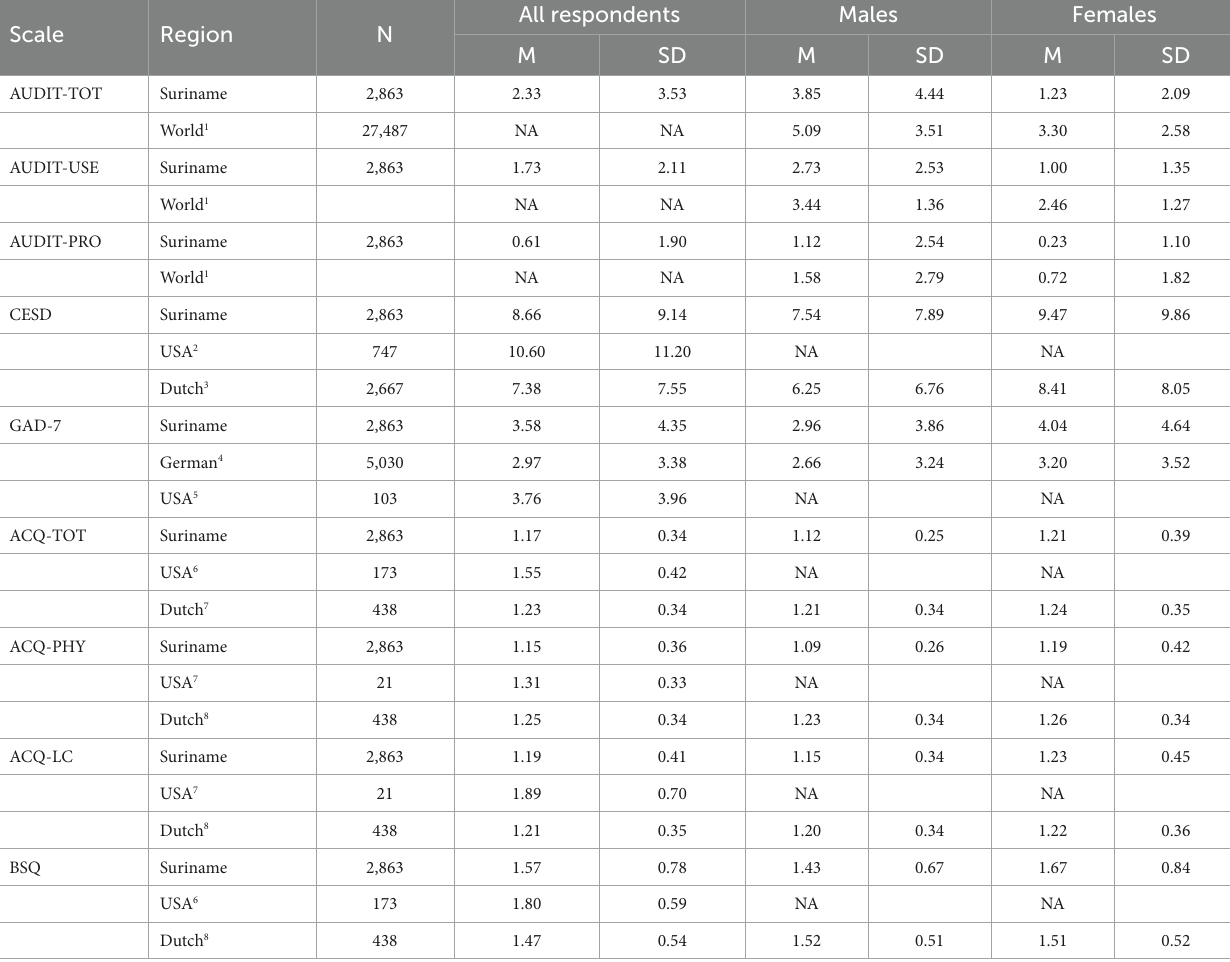
TABLE 3 Means and standard deviations on the instruments from Surinamese respondents and from other normative